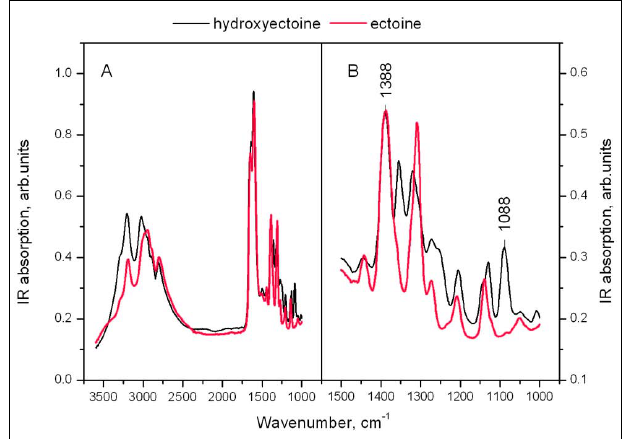
FIGURE 11 | (A) FTIR spectra of dry amorphous ectoine (red line) and hydroxyectoine at room temperature. The intensity of the spectra are normalized to the height of the peak at 1600 cm − 1 ; (B) enlarged finger print region of FTIR spectrum.